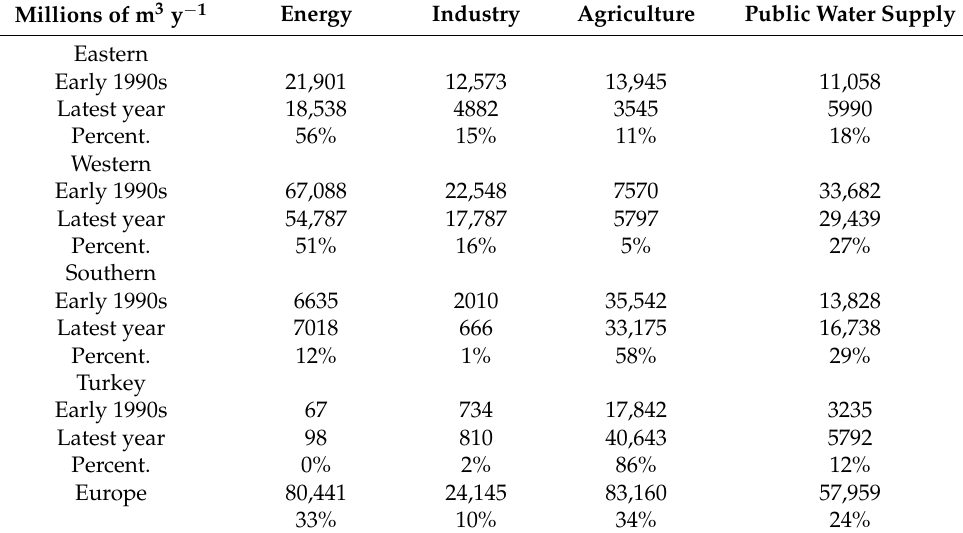
Table 1. Millions of cubic meters of water consumption in Europe * per year